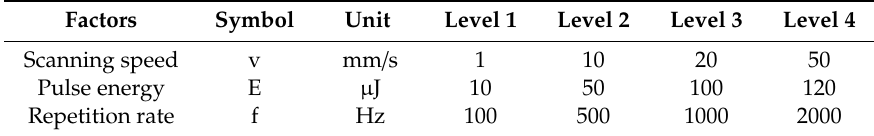
Table 4. Process parameters and design levels used in the L 16 (4 3 ) Taguchi